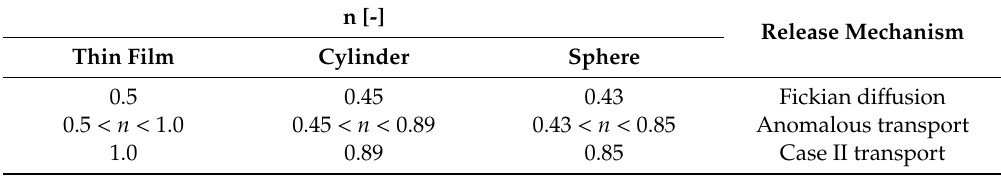
Table 2. Values of exponent n for di ff erent geometries. Taken from Siepmann and Peppas [107]. n